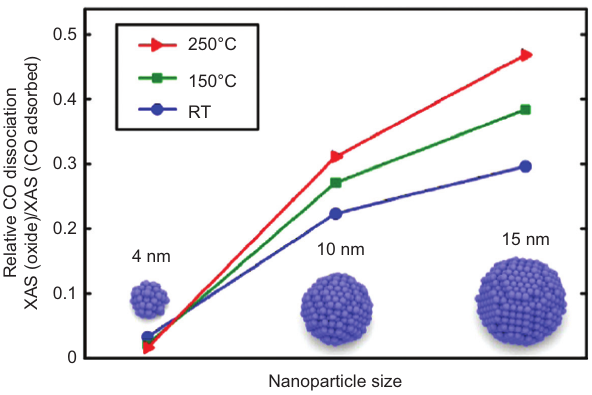
Figure 2 Apparent turnover frequencies (TOF) as a function of iron carbide size (TOS = 1 h).